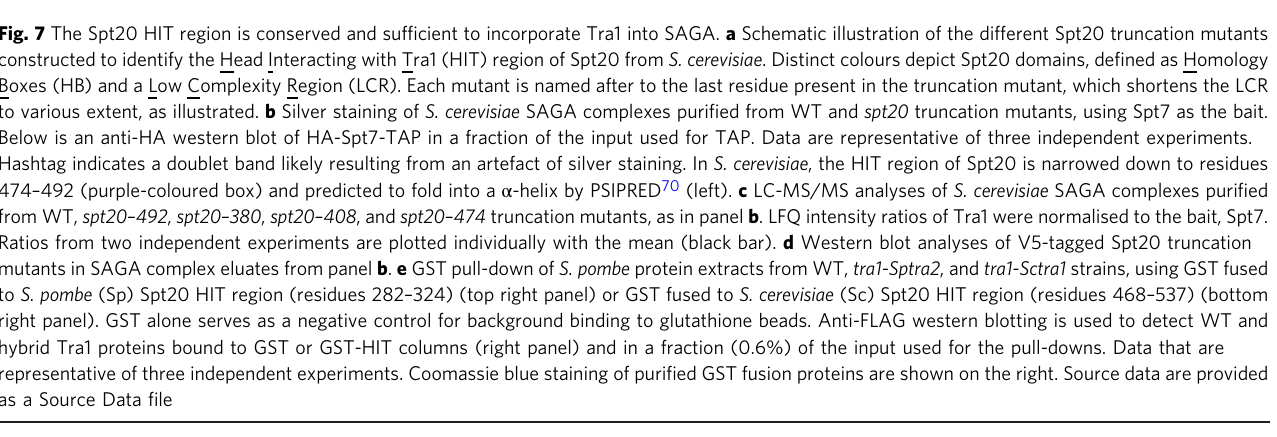
Fig. 7 The Spt20 HIT region is conserved and suf fi cient to incorporate Tra1 into SAGA. a Schematic illustration of the different Spt20 truncation mutants constructed to identify the Head Interacting with Tra1 (HIT) region of Spt20 from S. cerevisiae . Distinct colours depict Spt20 domains, de fi ned as Homology Boxes (HB) and a Low Complexity Region (LCR). Each mutant is named after to the last residue present in the truncation mutant, which shortens the LCR to various extent, as illustrated. b Silver staining of S. cerevisiae SAGA complexes puri fi ed from WT and spt20 truncation mutants, using Spt7 as the bait. Below is an anti-HA western blot of HA-Spt7-TAP in a fraction of the input used for TAP. Data are representative of three independent experiments. Hashtag indicates a doublet band likely resulting from an artefact of silver staining. In S. cerevisiae , the HIT region of Spt20 is narrowed down to residues 474 – 492 (purple-coloured box) and predicted to fold into a α -helix by PSIPRED 70 (left). c LC-MS/MS analyses of S. cerevisiae SAGA complexes puri fi ed from WT, spt20 – 492 , spt20 – 380 , spt20 – 408 , and spt20 – 474 truncation mutants, as in panel b . LFQ intensity ratios of Tra1 were normalised to the bait, Spt7. Ratios from two independent experiments are plotted individually with the mean (black bar). d Western blot analyses of V5-tagged Spt20 truncation mutants in SAGA complex eluates from panel b . e GST pull-down of S. pombe protein extracts from WT, tra1-Sptra2 , and tra1-Sctra1 strains, using GST fused to S. pombe (Sp) Spt20 HIT region (residues 282 – 324) (top right panel) or GST fused to S. cerevisiae (Sc) Spt20 HIT region (residues 468 – 537) (bottom right panel). GST alone serves as a negative control for background binding to glutathione beads. Anti-FLAG western blotting is used to detect WT and hybrid Tra1 proteins bound to GST or GST-HIT columns (right panel) and in a fraction (0.6%) of the input used for the pull-downs. Data that are representative of three independent experiments. Coomassie blue staining of puri fi ed GST fusion proteins are shown on the right. Source data are